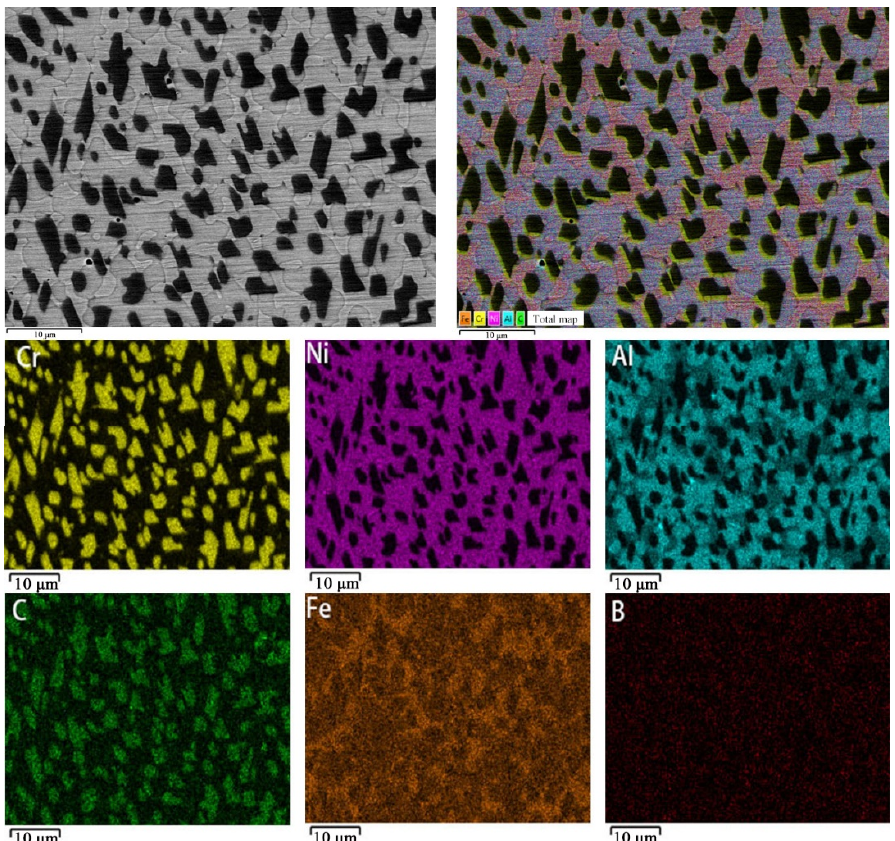
Figure 8. Element distribution map of the alloyed powder cladding layer.